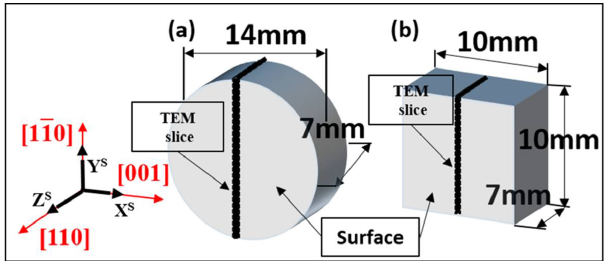
Figure 1. The size and surface orientation of the cylinder ( a ) and tetragonal ( b ) samples. SEM investigation is performed on the surface; TEM slices were cut from the black position.